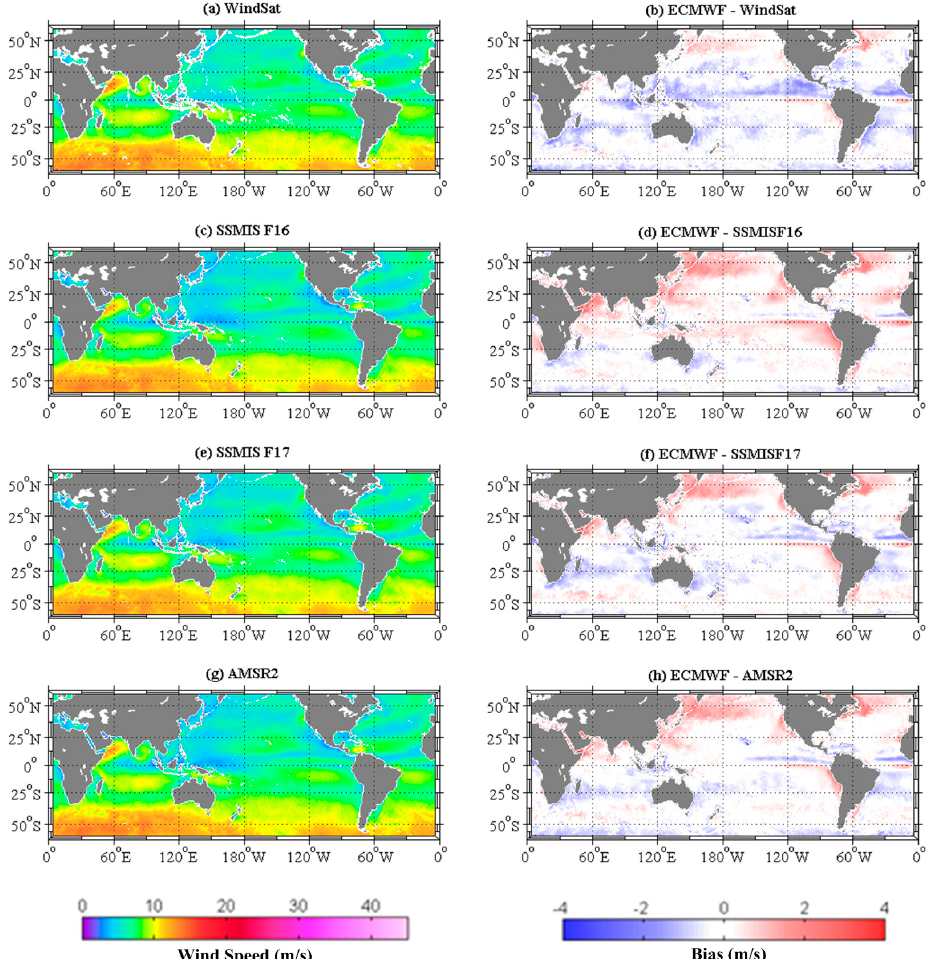
Figure 9. Maps of mean monthly (in July) wind speeds derived from four different satellites during the periods 2013–2017: ( a ) WindSat; ( c ) SSMIS F16; ( e ) SSMIS F17; and ( g ) AMSR2. The corresponding wind speed differences between each satellite and ECMWF: ( b ) ECMWF–WindSat; ( d ) ECMWF–SSMIS F16; ( f ) ECMWF–SSMIS F17; and ( h ) ECMWF–AMSR2.